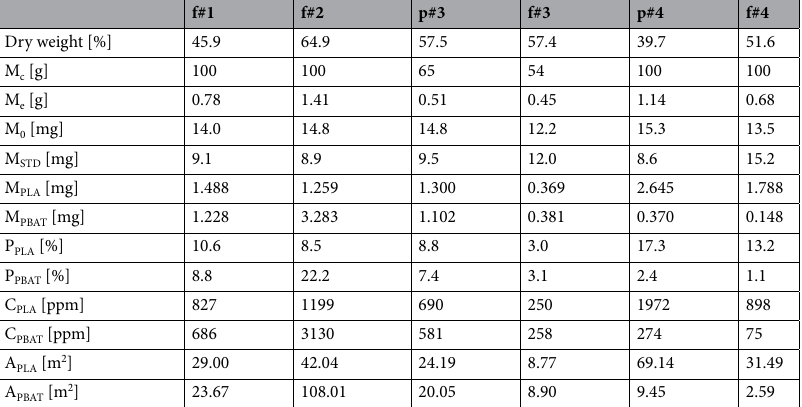
Table 4. Evidence of PBAT and PLA residues caused by fragments < 1 mm in the composts. M c : mass of dry compost subjected to extraction; M e : mass extracted from compost sample; M 0 : mass of material used for 1 H NMR; M STD : mass internal standard used for 1 H NMR; M PLA , M PBAT : masses of PLA and PBAT in M 0 ; P PLA ,